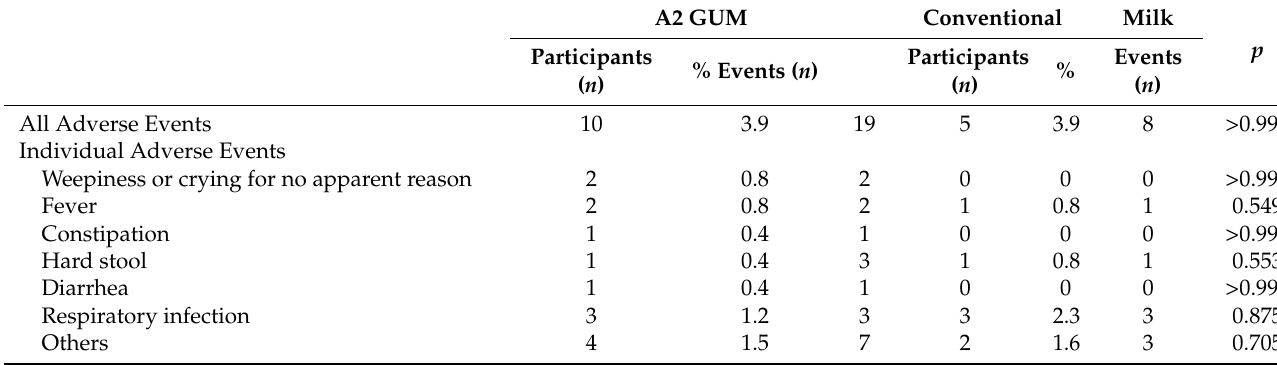
Table 5. Adverse events during the study